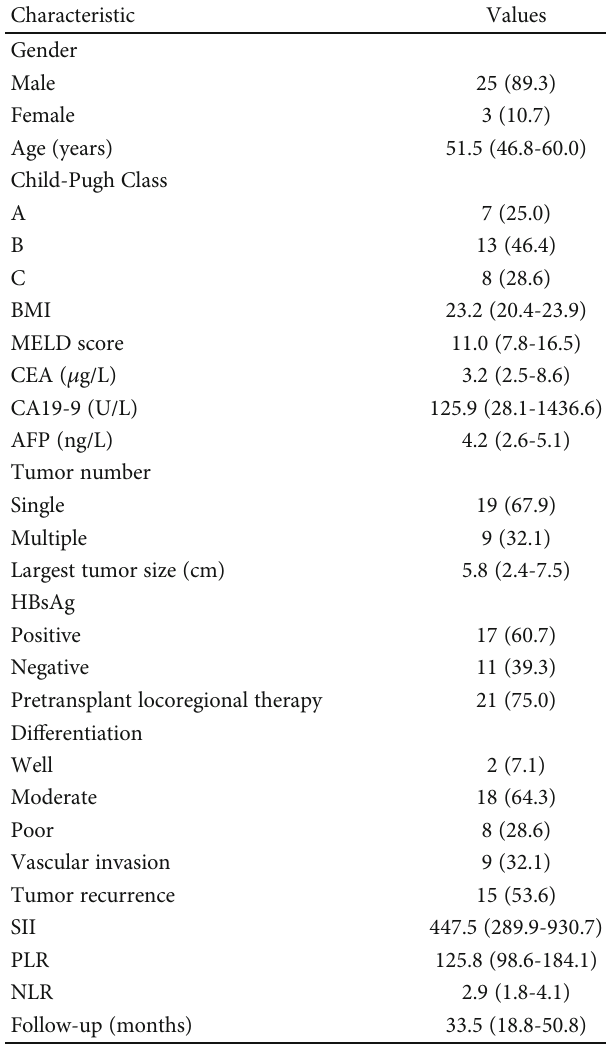
Table 1: Baseline characteristics in iCCA